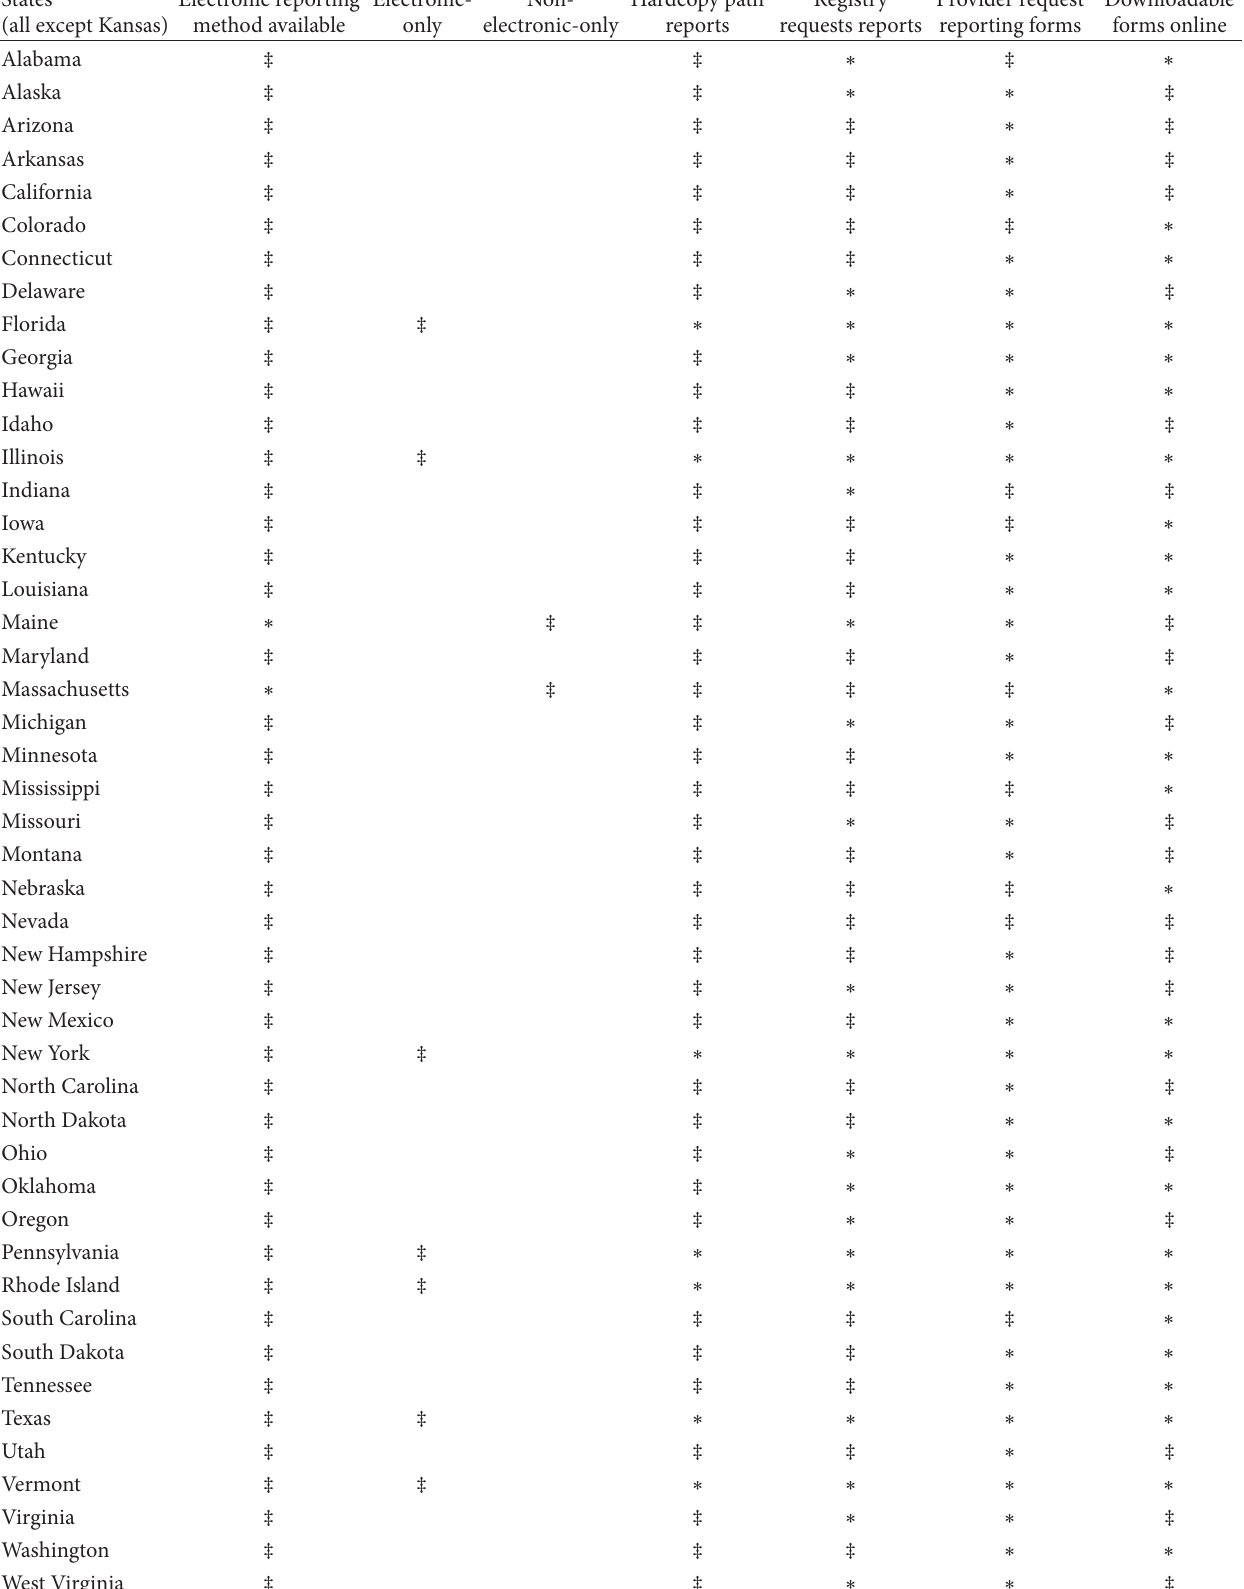
Table 1: Reporting methods available to mandated melanoma reporters across US state cancer registries.